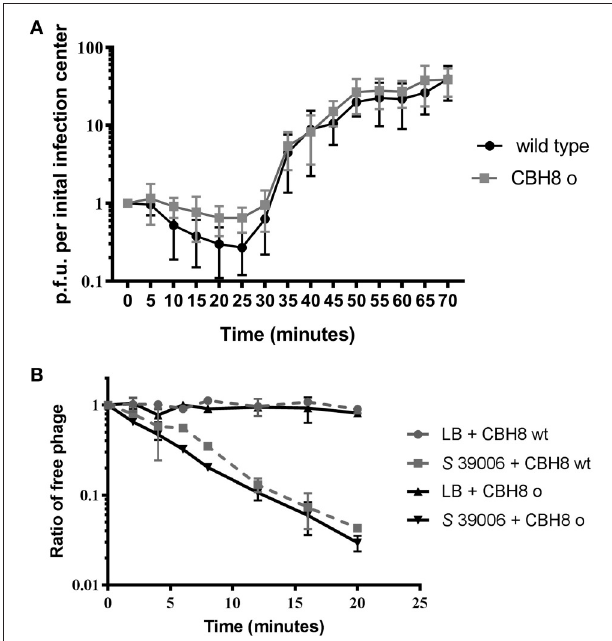
FIGURE 6 | Fitness comparison of 8 CBH8wt and 8 CBH8o. (A) One-step growth curve of 8 CBH8wt and 8 CBH8o. (B) Adsorption of 8 CBH8wt and 8 CBH8o to wild type S 39006. 8 CBH8wt and 8 CBH8o with LB-only was used as a negative control for